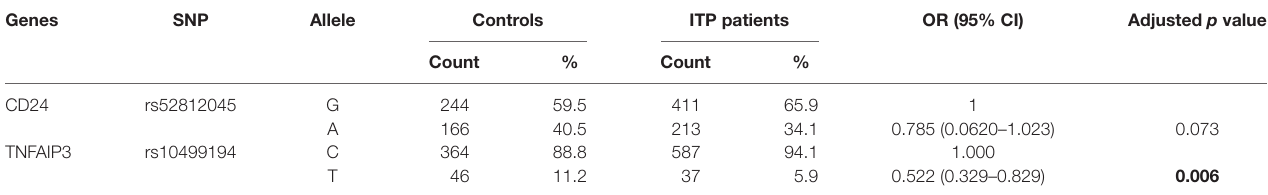
TaBle 5 | Association between selected SNPs and ITP risk in allelic analysis.